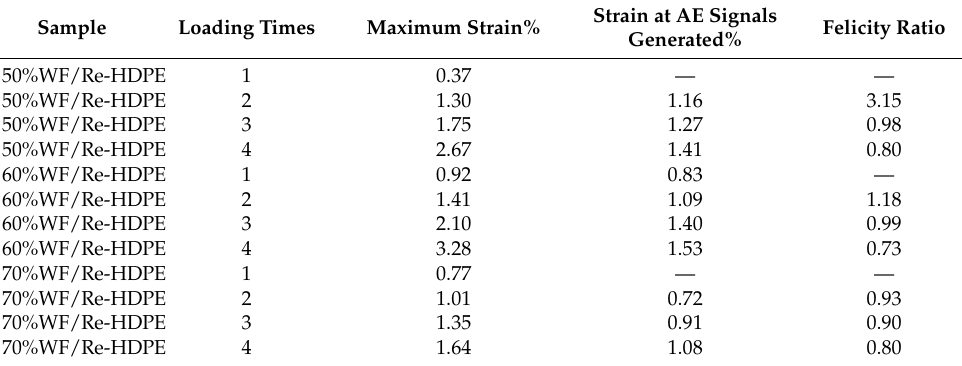
Figure 10. Time-strain curve, AE accumulative counts, and ringing counts of WF/Re-HDPE composites with different WF contents. The blue circle represents accumulative counts and ringing counts in Figure 10 a – f , respectively. Table 2. Felicity ratio of WF/Re-HDPE composites with different WF content.